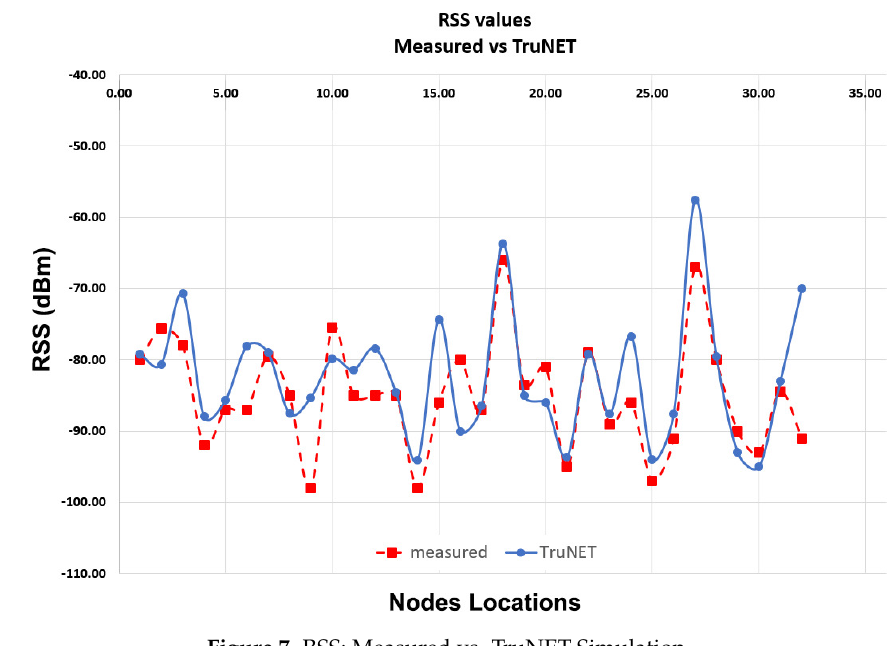
Figure 7. RSS: Measured vs. TruNET Simulation.